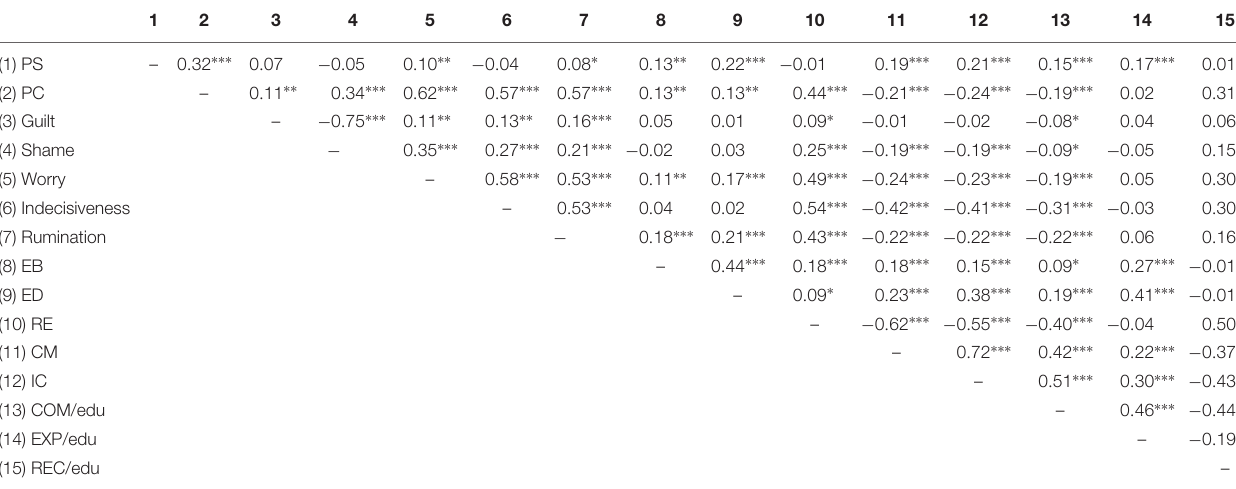
TABLE 1 | Correlations between the analyzed